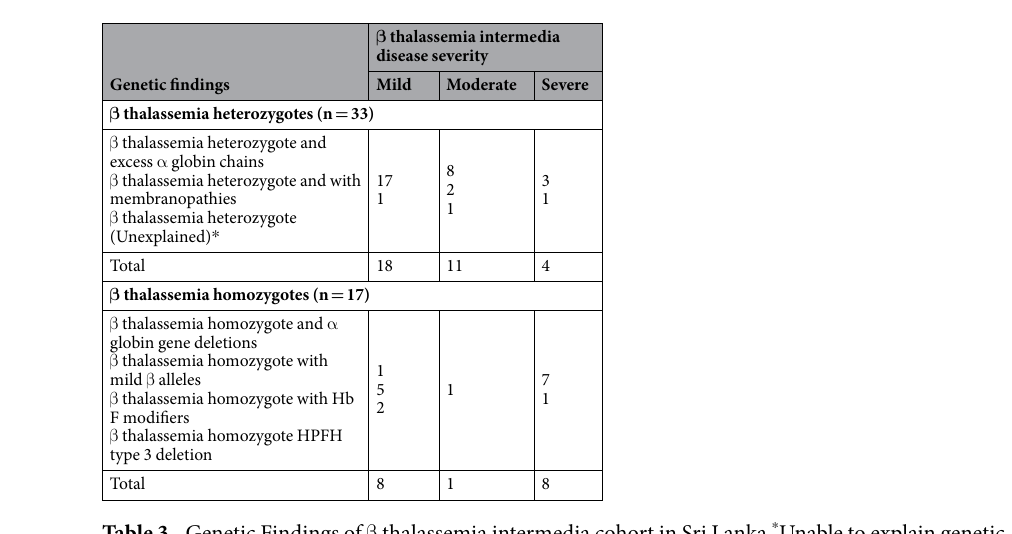
Table 3. Genetic Findings of β thalassemia intermedia cohort in Sri Lanka * Unable to explain genetic mechanism for the phenotypic diversity from the available genetic